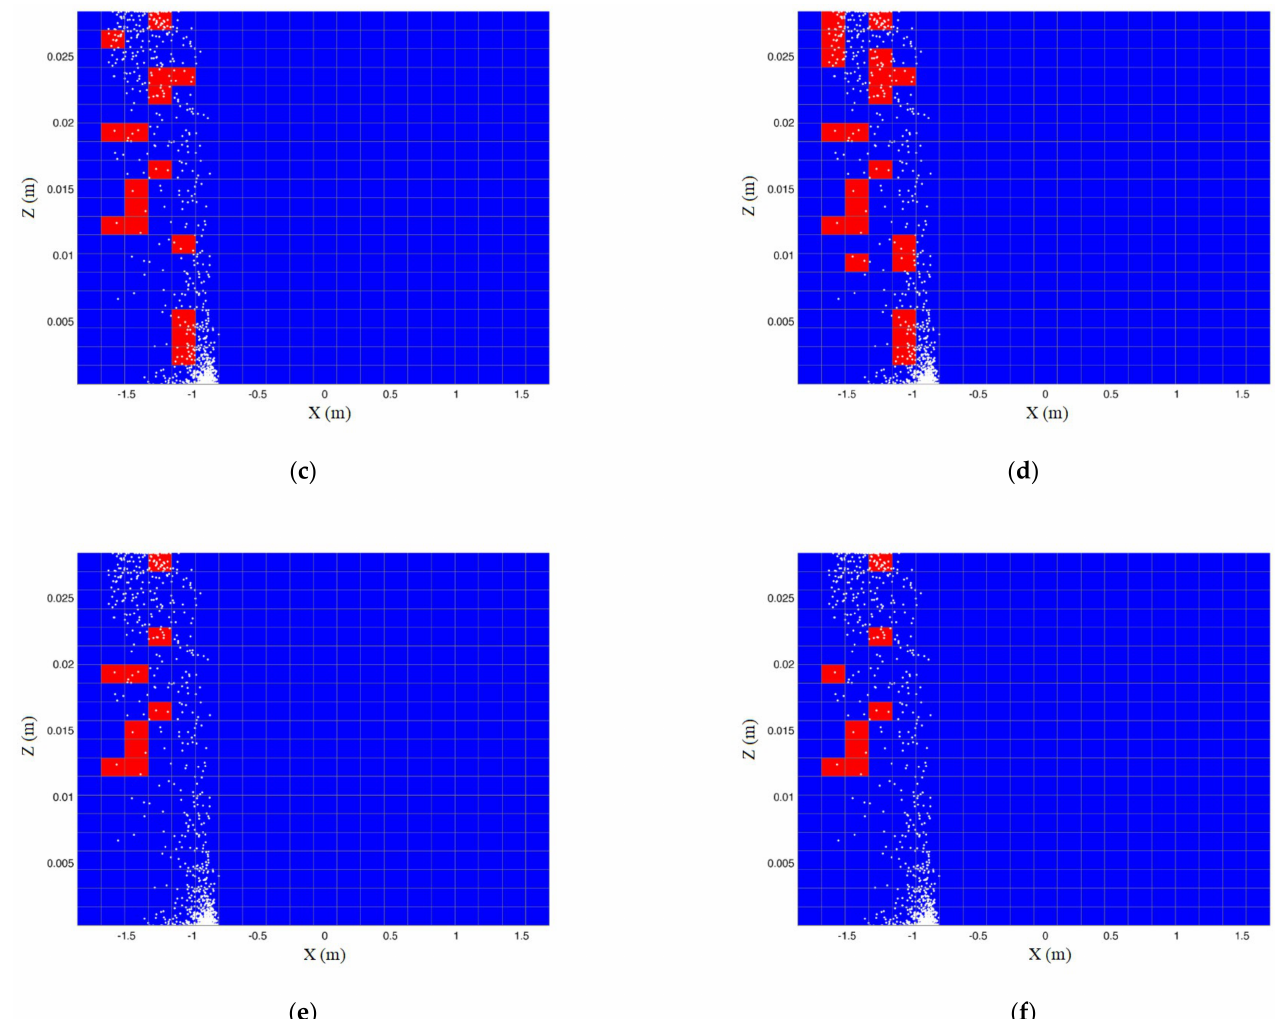
Figure 12. Probable source regions with different threshold values; ( a ) threshold value is 1; ( b ) threshold value is 0.8; ( c ) threshold value is 0.6; ( d ) threshold value is 0.4; ( e ) threshold value is 0.2; ( f ) threshold value is